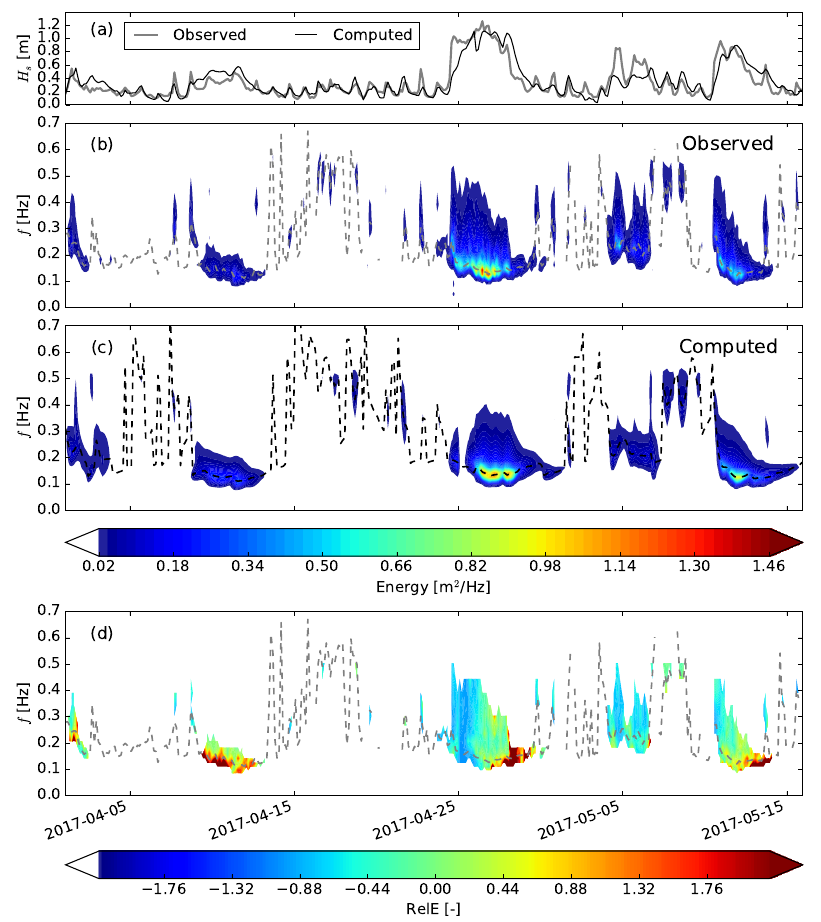
Figure 11. Temporal variation of 1D frequency spectra. ( a ) H s time series. ( b ) Observed frequency spectra. ( c ) Computed frequency spectra. ( d ) Relative error of spectral energy density. Grey and black dashed lines are, respectively, the observed and computed peak